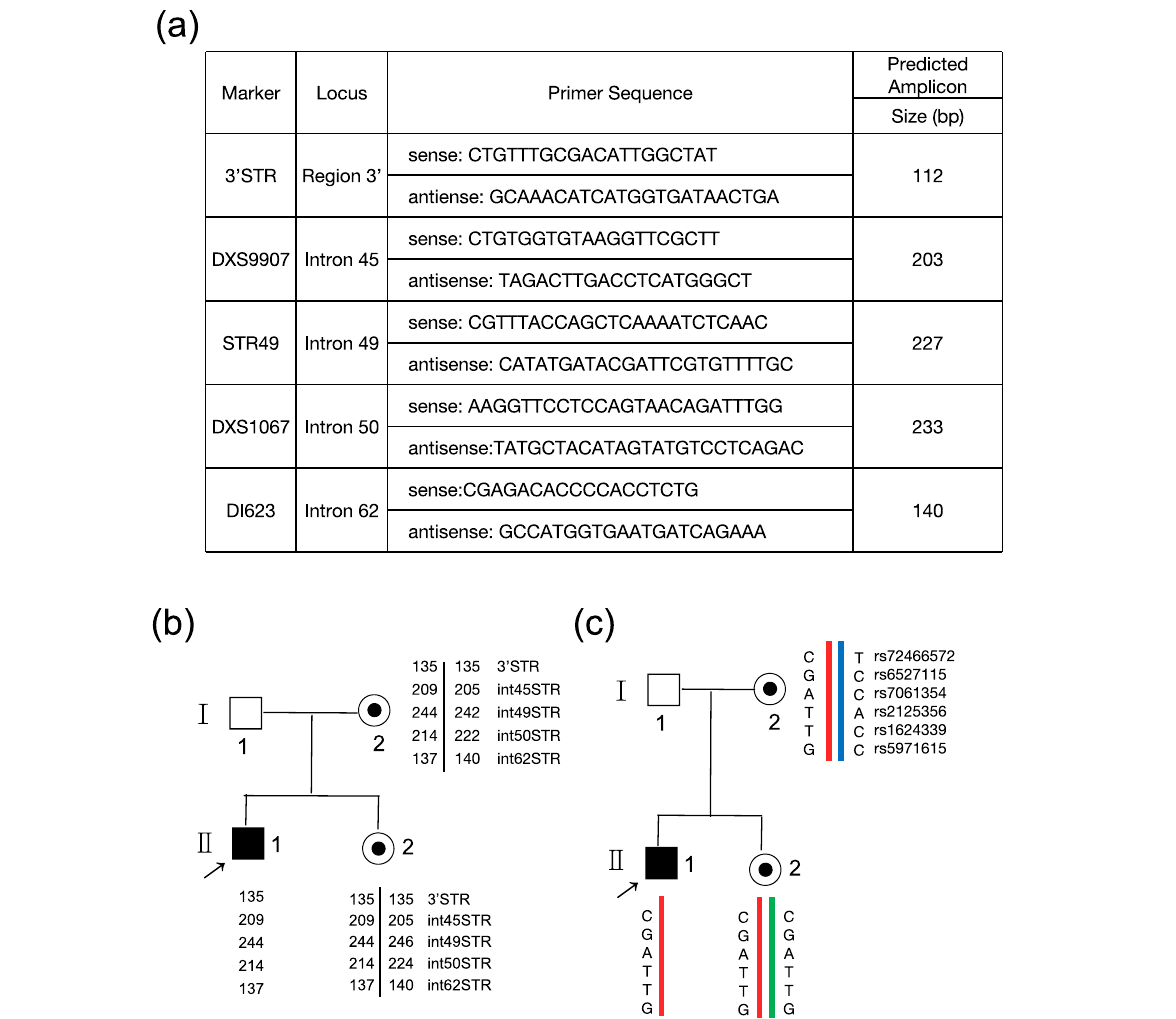
Fig. 4 Chromosome distribution of the two mutations. a Primers for the detection of DMD STR locus. b STR analysis result in the indicated pedigree. c The sequencing result of the adjacent representative six SNPs near the mutation regions. Through the linkage genetic analysis using informative STR and SNPs, it was deduced that the mutant allele was inherited from the same chromosome of the